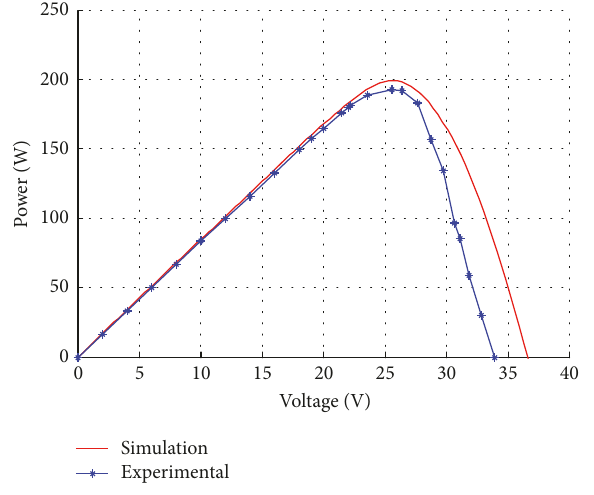
Figure 20: The 𝑃 - 𝑉 characteristics of PFV ALTIUS 235W.